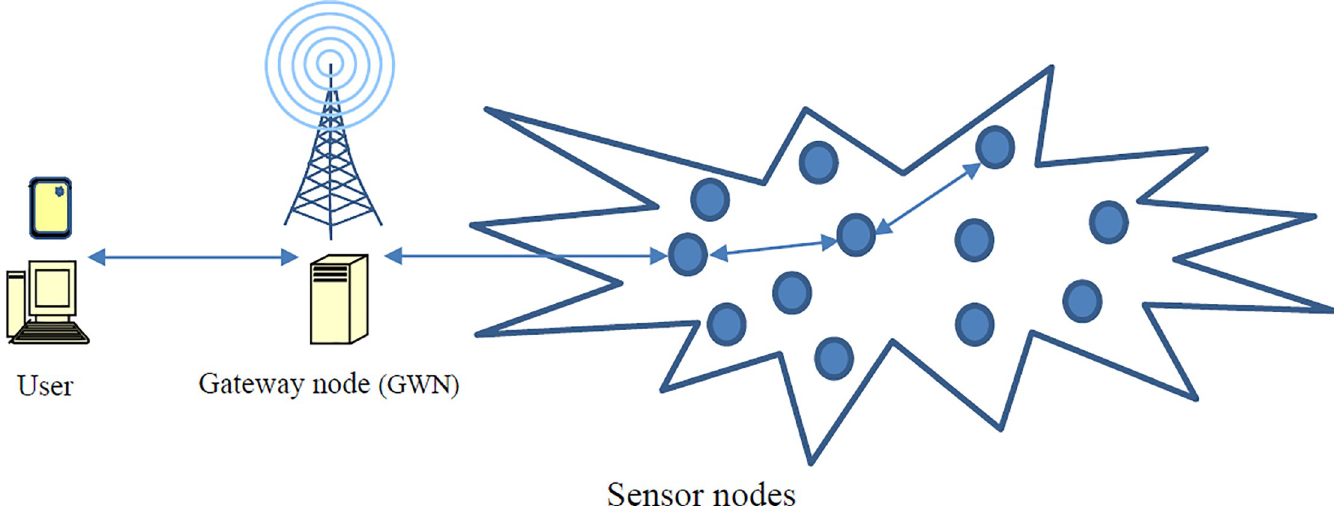
Fig 1. Wireless sensor